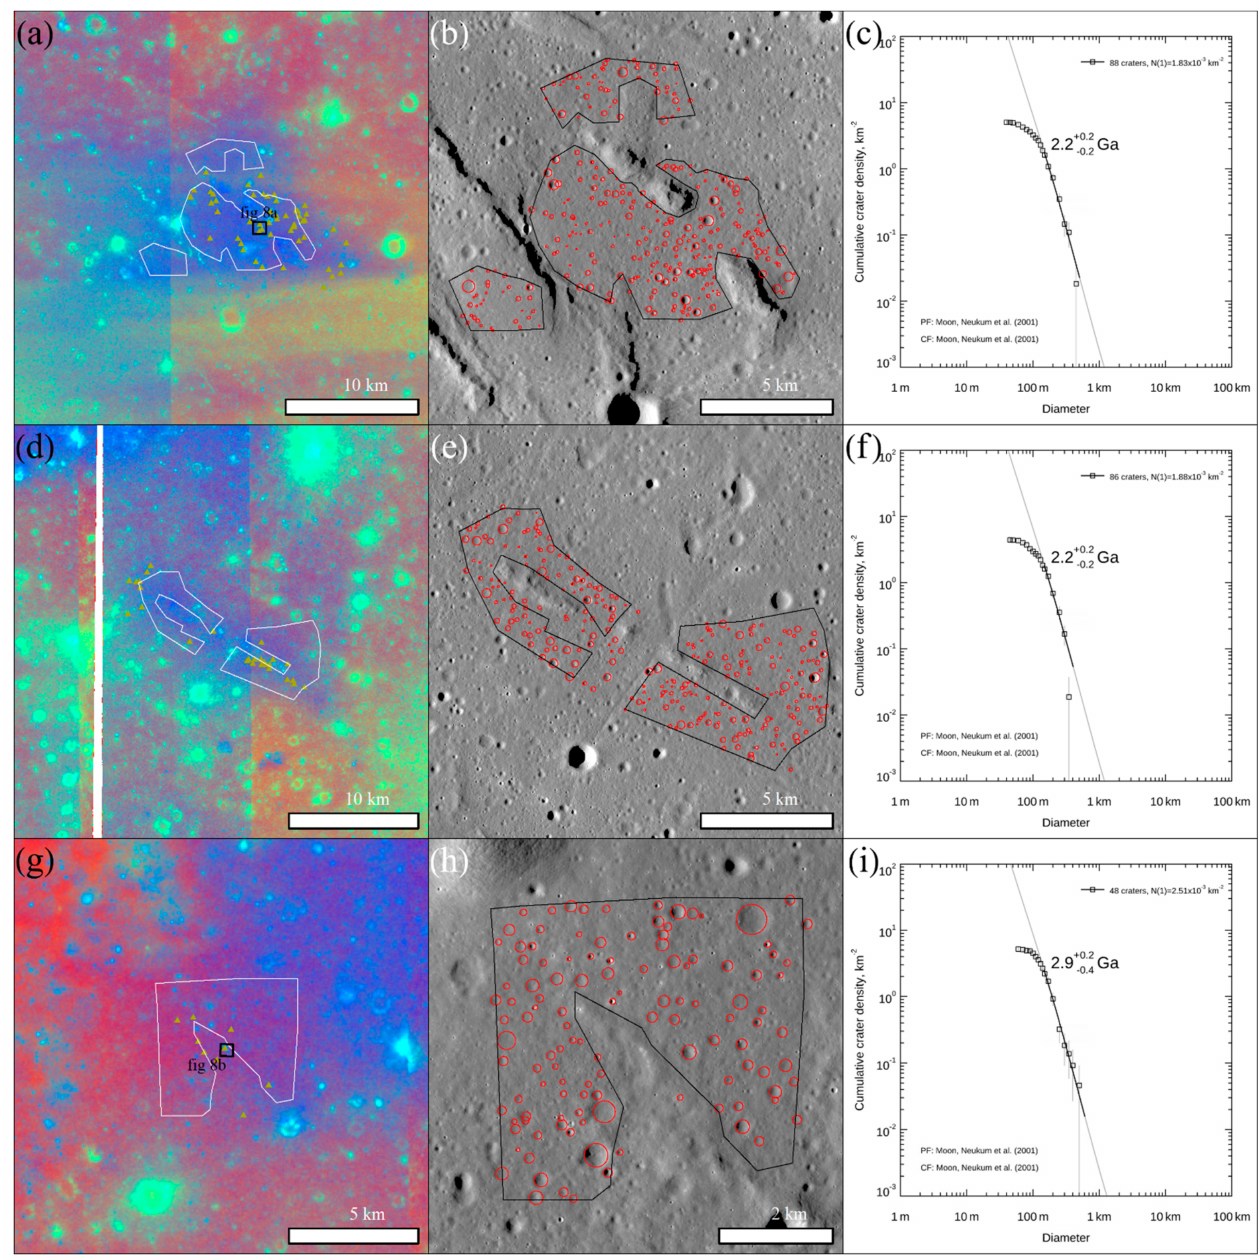
Figure 5. Crater size–frequency distribution measurements of three Eratosthenian-aged basalt areas with IMPs (dark yellow triangles); craters with diameter > 150 m are used for dating. ( a ) MI color ratio map of counting area 1 (2.0 ◦ S, 43.2 ◦ E); ( b ) crater counting of area 1, shown with a Terrain Camera (TC, [53]) image; ( c ) absolute model age of area 1; ( d ) MI color ratio map of counting area 2 (0.4 ◦ S, 43.0 ◦ E); ( e ) crater counting of area 2, shown with a TC image; ( f ) absolute model age of area 2; ( g ) MI color ratio map of counting area 3 (0.1 ◦ N, 42.4 ◦ E); ( h ) crater counting of area 3, shown with a TC image; ( i ) absolute model age of area 3. The black boxes represent the locations of other figures in this